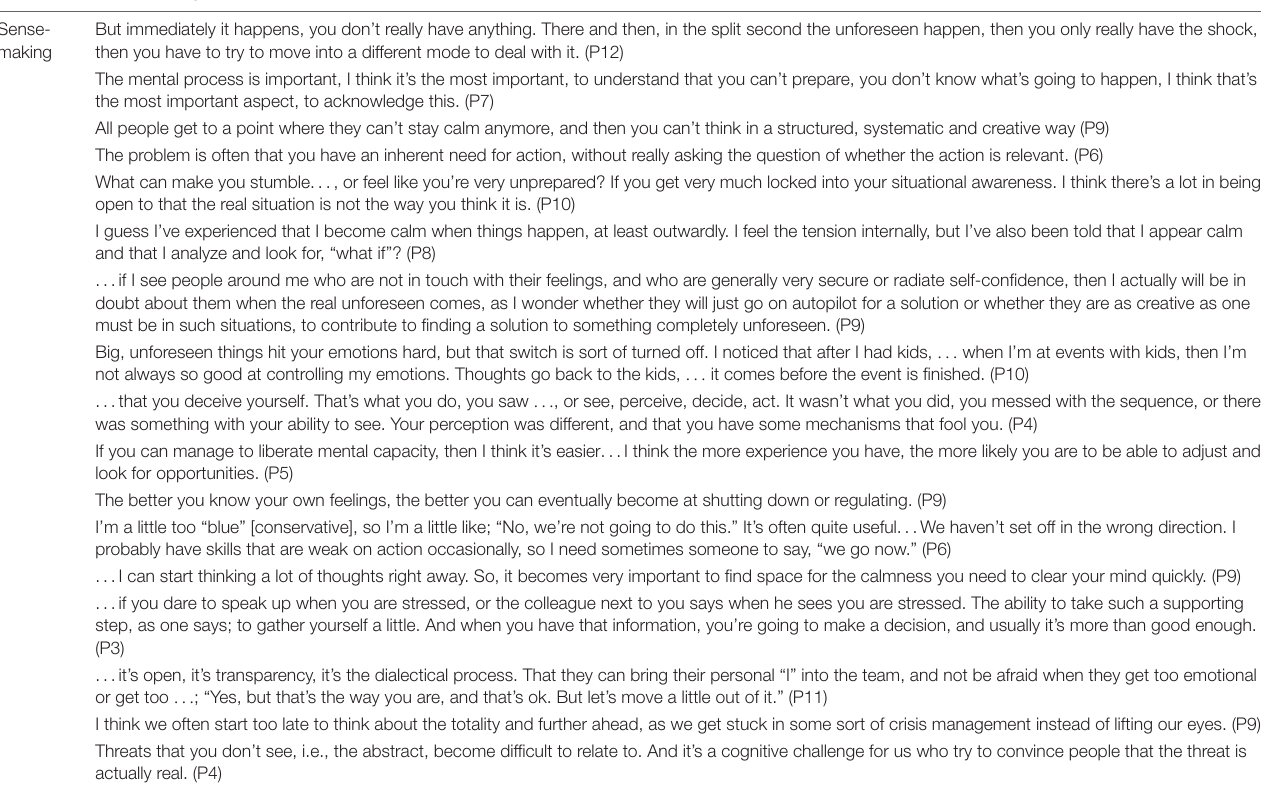
TABLE 10 | Quotes from experts illustrating the role of emotions in sensemaking and